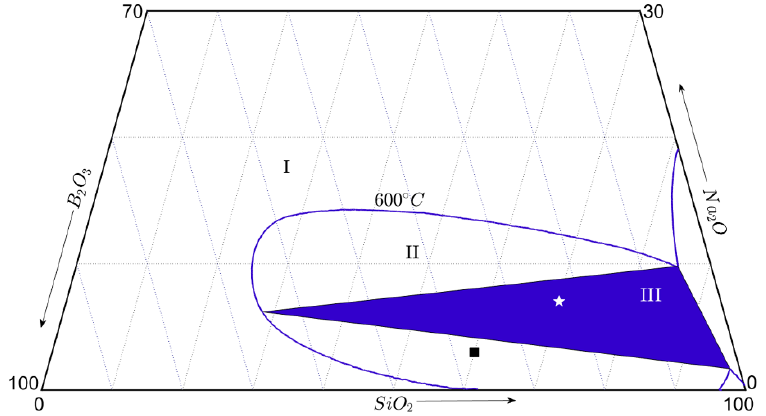
Figure 5. Ternary SBN oxide glass system with Haller’s isothermals acquired from clearing temperatures. Data points correspond to data presented in two of Haller’s papers for pseudo -ternary SBN systems (circles [83]) and SiO 2 -Na 2 O systems (triangles [81]). The colors correspond to the clearing temperature. Arrows indicate the direction of increasing mol%. Recreated with data in [81,83].